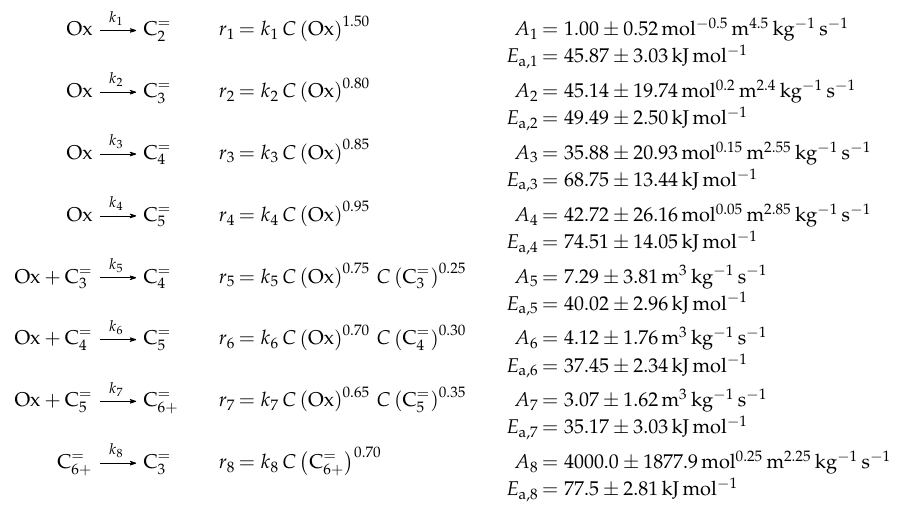
Scheme 17. Reaction network, rate equations and estimated parameters for the model by Menges and Kraushaar-Czarnetzki